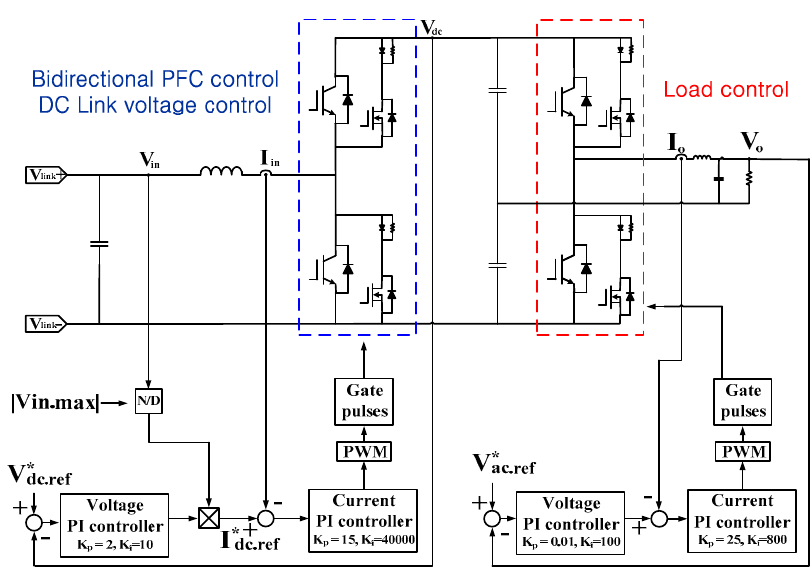
Figure 6. Configuration of the low ‐ voltage side of a bidirectional converter.